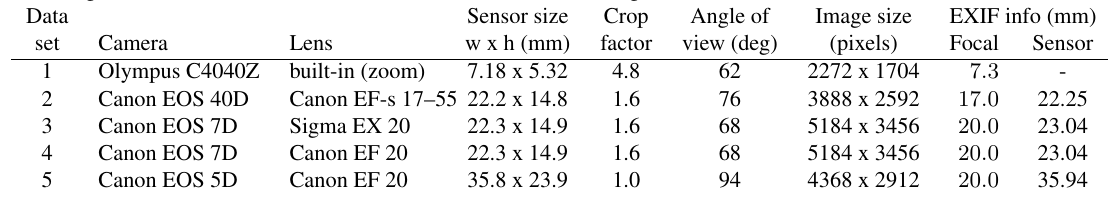
Table 1: The cameras and lenses used in the experiments. The listed crop factor is the ratio of the diagonal of the 35mm film format (36-by-24 mm) to the sensor diagonal. The angle of view value is computed across the sensor diagonal. All cameras were focused at infinity. Zoom lenses were set at their smallest setting. The sensor sizes have been retrieved from public sources. The EXIF info shows what focal length and/or sensor width information was available in the images.